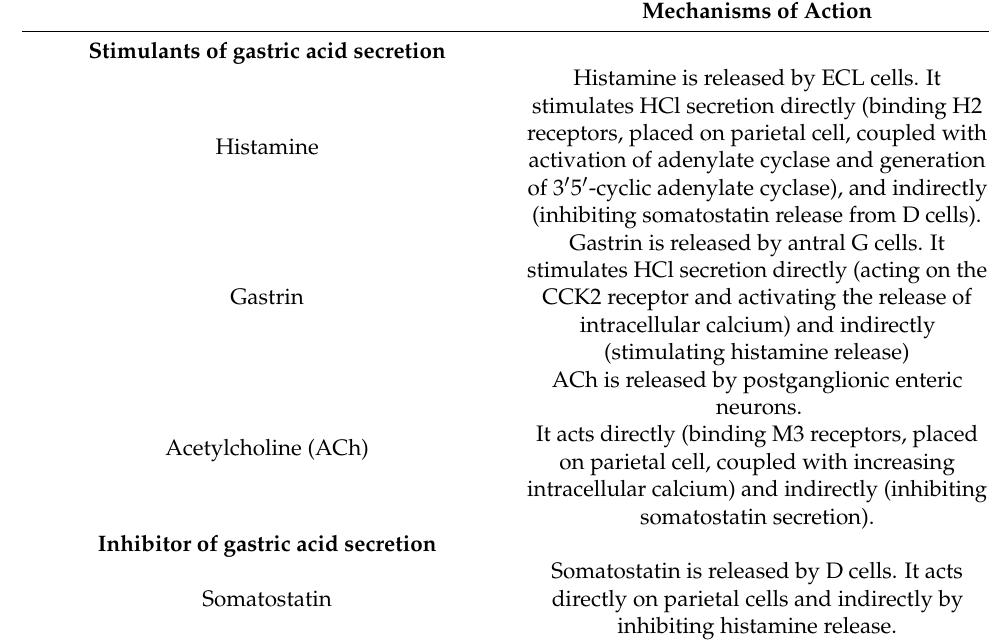
Mechanisms of Action